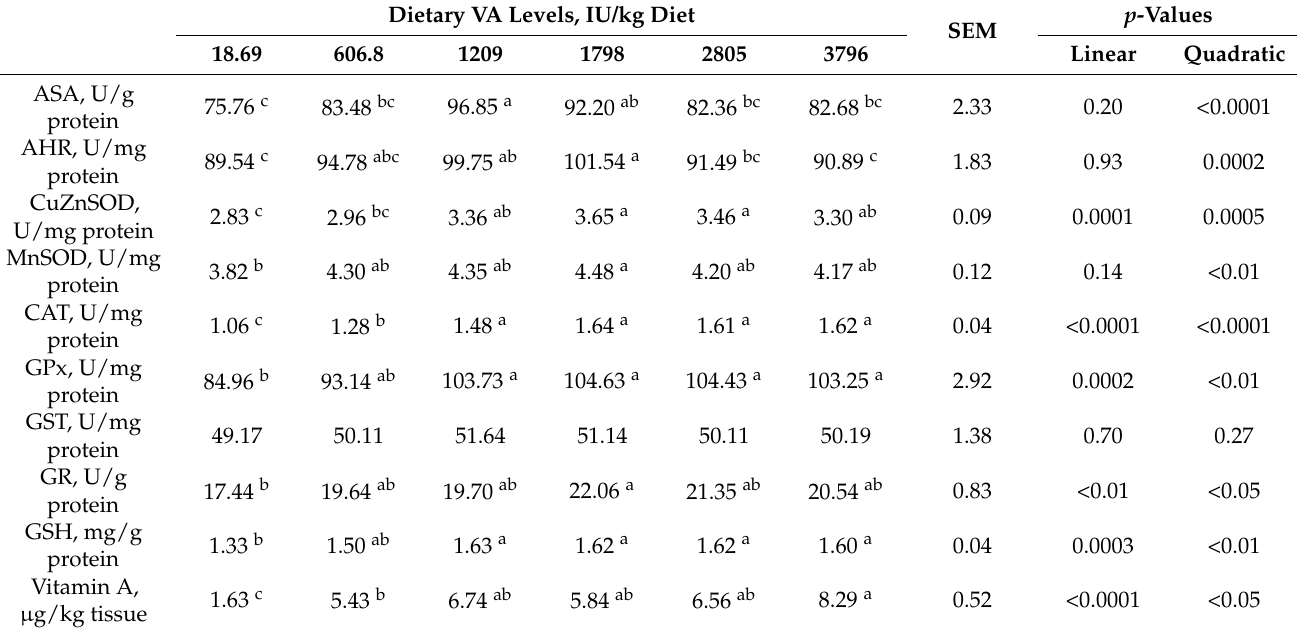
Table 6. Effect of dietary vitamin A on antioxidant parameters in muscle of on-growing grass carp 1 . Dietary VA Levels, IU/kg Diet